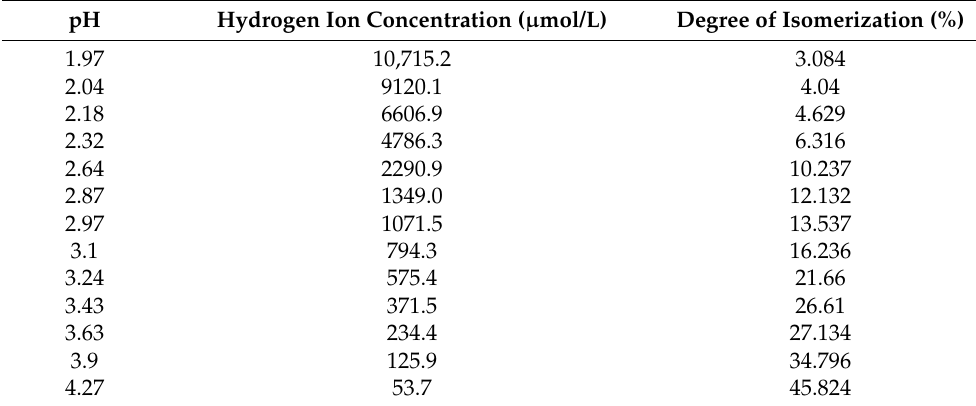
Figure 7. Relationship between pH and degree of isomerization ( n = 3). Table 7. Relationship between pH and degree of isomerization ( n =